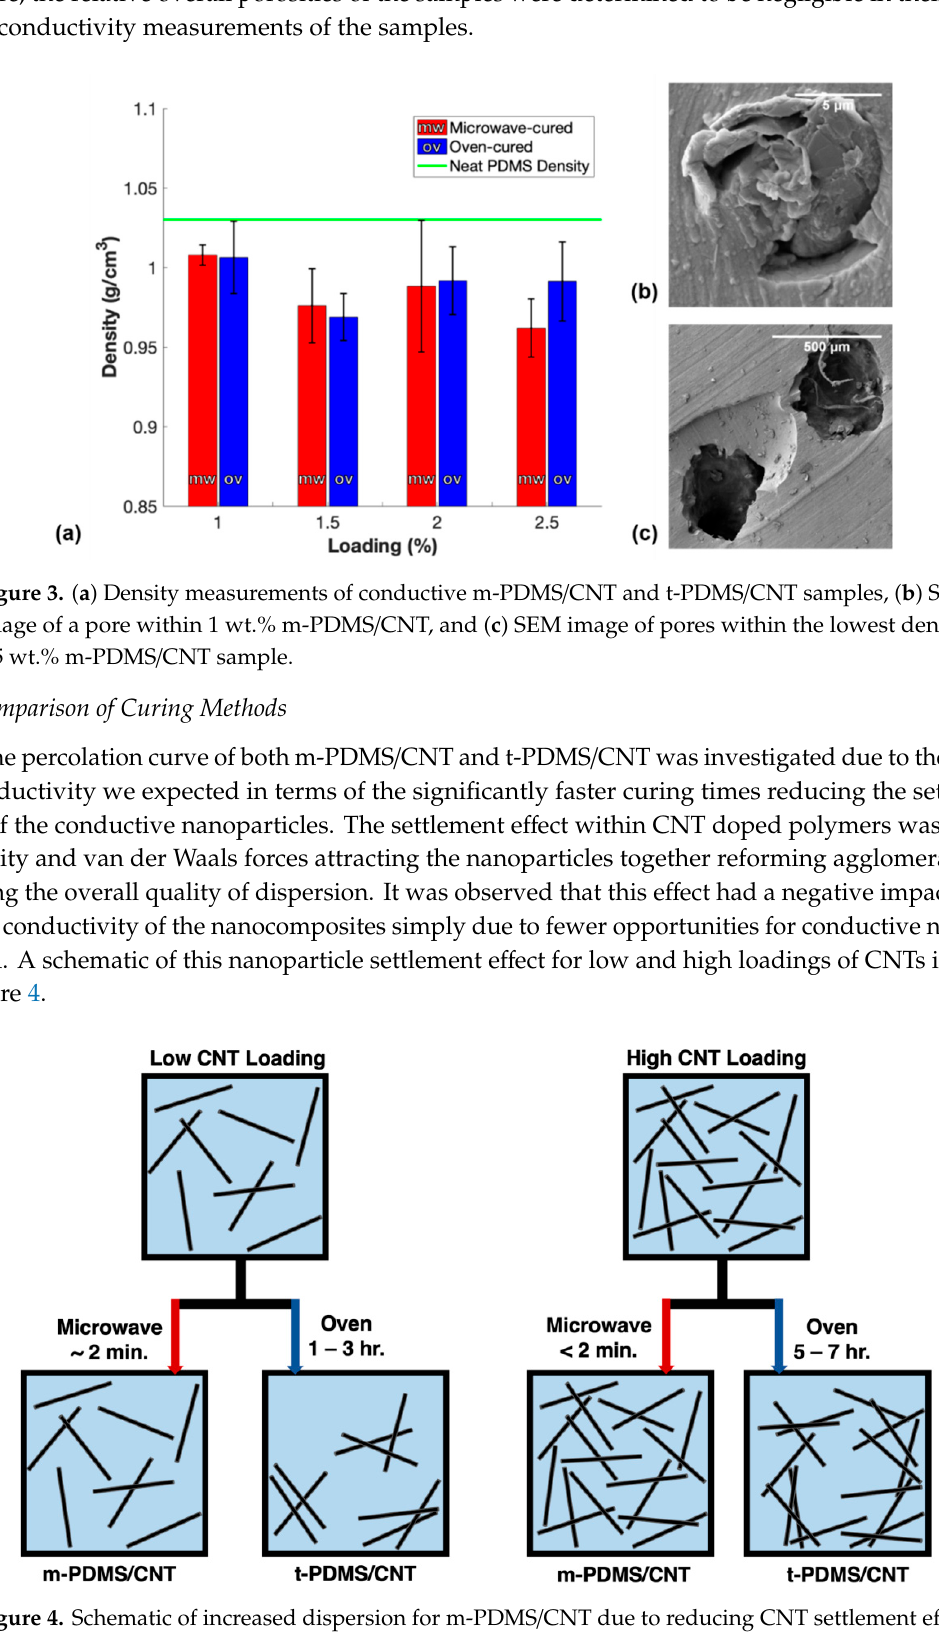
Figure 3. ( a ) Density measurements of conductive m-PDMS/CNT and t-PDMS/CNT samples, ( b ) SEM image of a pore within 1 wt.% m-PDMS/CNT, and ( c ) SEM image of pores within the lowest density 2.5 wt.% m-PDMS/CNT sample.